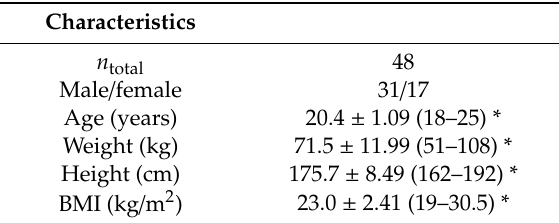
Table 1. Participant